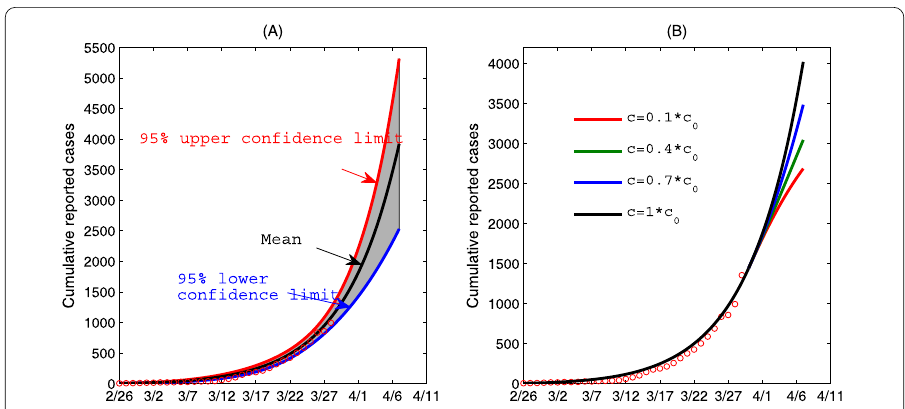
Figure 3 ( A ) The impact of the randomness of the data of cumulative confirmed cases on the epidemics in Ontario. ( B ) The impact of contact rate on the cumulative confirmed cases, where we assumed that the contact rate decreases since March 30th. Here, c 0 is the estimated value based on the fitting results in ( A )